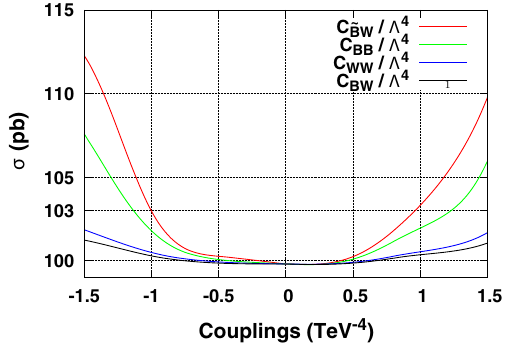
Fig. 2 Cross-sections for the process with aNTGCs including CP- conserving and CP-violating terms in the Lagrangian distribution functions (PDFs) for all simulated MC samples.